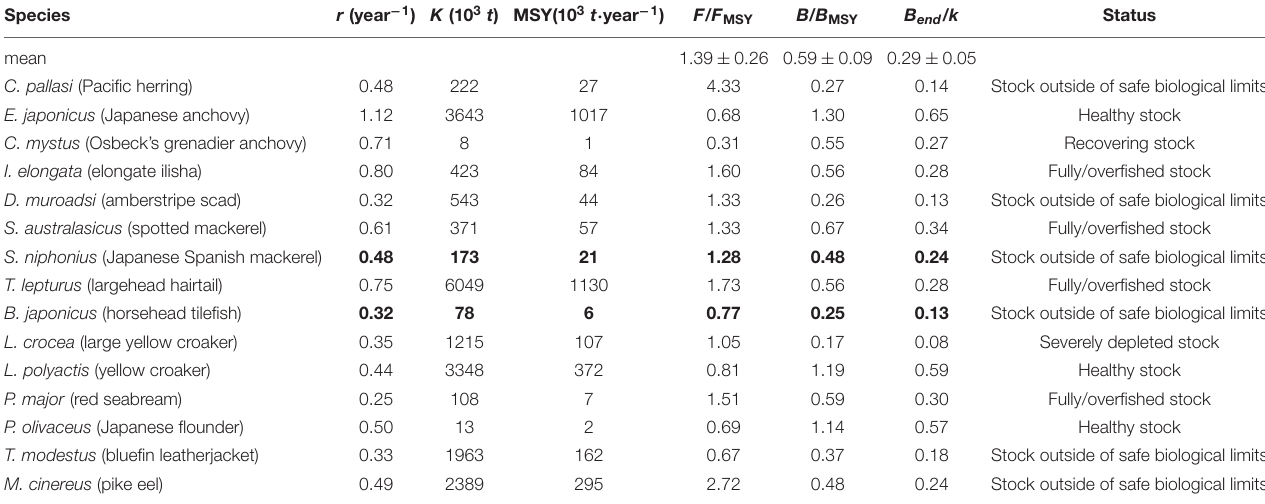
FIGURE 1 | Examples of the identification of viable and best trajectories (as defined by values of r and k ), for the populations of (A) Japanese Spanish mackerel ( S. niphonius ) and (B) Japanese anchovy ( E. japonicus ). In (A) , the viable r - k pairs (gray) were obtained by the CMSY method, and the solid crosses identify the most probable r - k pairs, along with their 95% confidence intervals; in (B) , the viable r - k pairs (black) were obtained by the BSM method, the dotted cross identifies the most probable r - k pair, and its 95% confidence intervals. TABLE 5 | Estimates of r , k , MSY, B / B MSY and status as obtained by CMSY and/or BSM method for 15 fish stocks of China’s coastal seas. The result in normal font are based on the BSM method, i.e., they used catch and additional relative abundance data; the results in bold font are only based on catch time series and CMSY*.